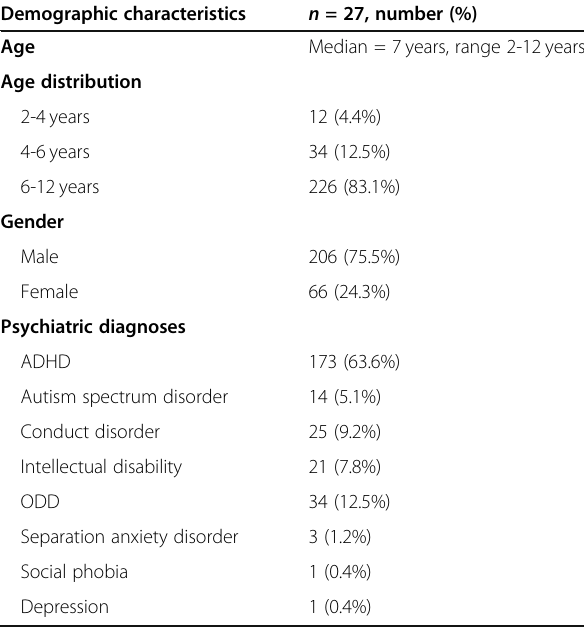
Table 1 Sample characteristics Demographic characteristics